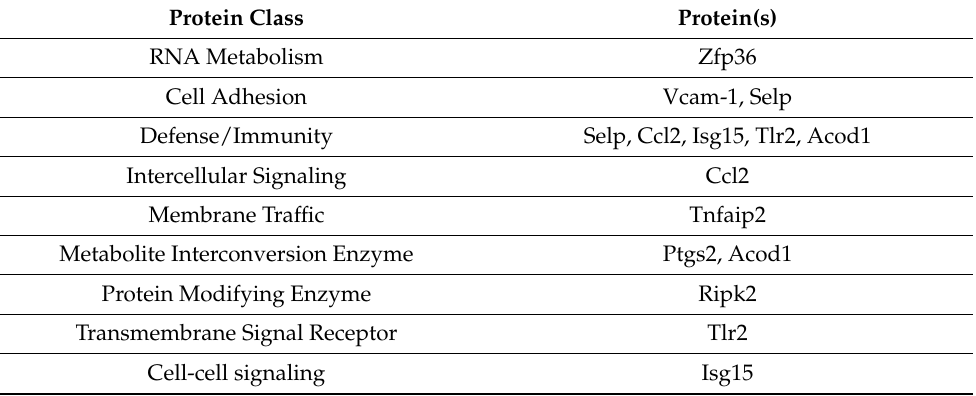
Figure 4. Functional enrichment analysis showing the top 5 GO BPs expressed in the ECs. Over time, 4 of the top 5 GO BPs observed in the upregulated proteins at 4 h (panel A ) are also present at 24 h (panel B ). There were no BPs observed in the downregulated proteins at 4 h, but at 24 h (panel C ), 4 and 5 significant GO BPs were identified in the liver and kidney, respectively. Table 1. The PANTHER/GeneCards classes of 10 of the proteins that have the highest level of upregulation compared to control at 4 h post cytomix treatment. As shown, most proteins are categorized within the defense/immunity, cell adhesion and metabolite interconversion enzyme classes and belong to multiple classes.